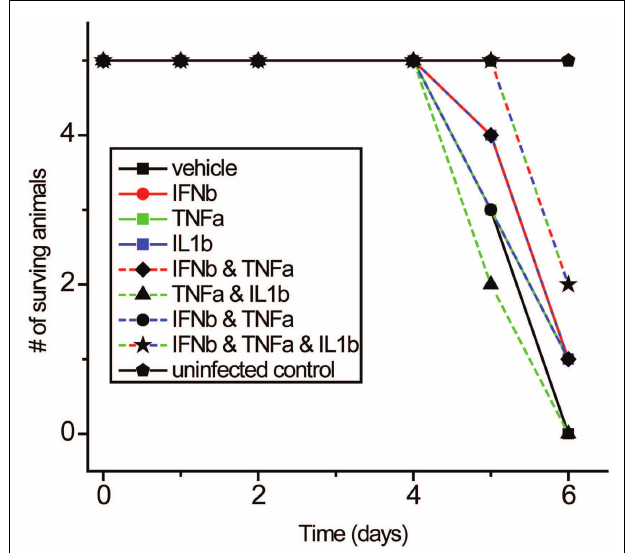
FIGURE 11 | Effects of IFN β ,TNF α , and IL1 β combinations on mortality with PR8 virus in vivo . Mice received cytokine injection i.p. 6h before and 6h after infection with PR8